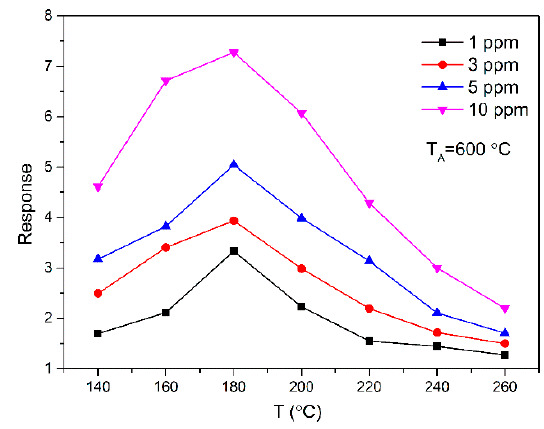
Figure 4. Response of sensors based on SnO 2 nanoparticles versus operating temperature to 1, 3, 5, and 10 ppm acetone, respectively.